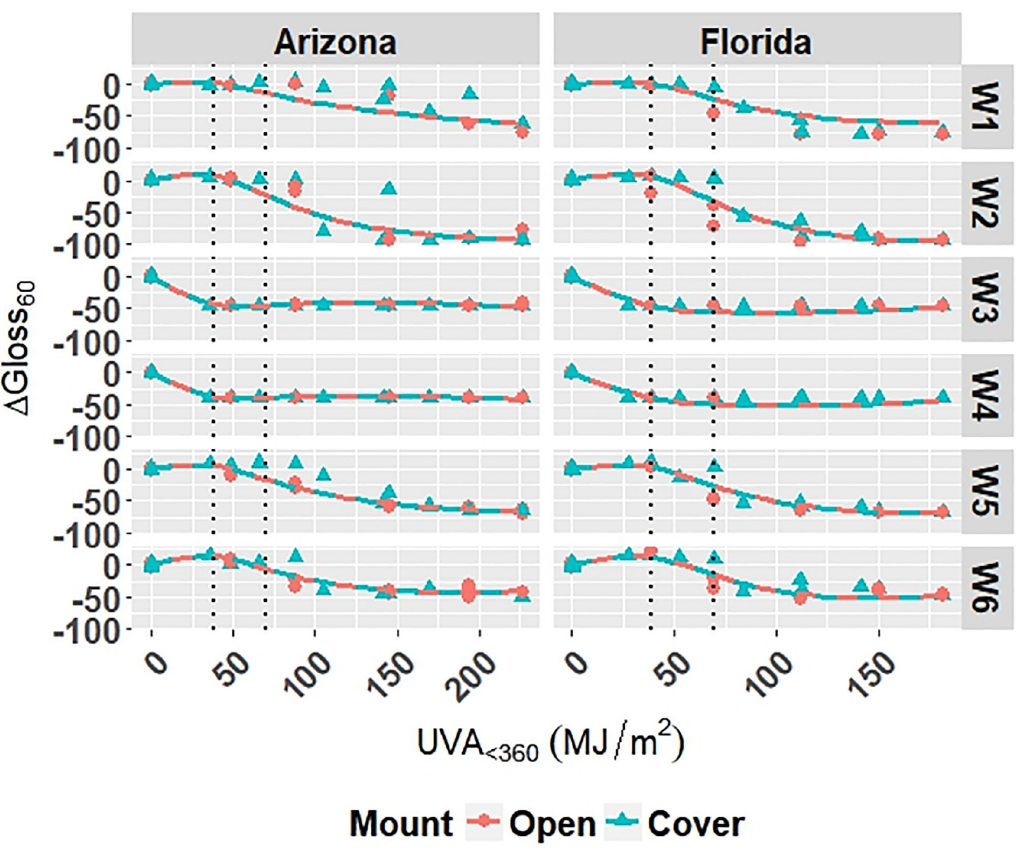
Fig 5. The change in Δ Gloss 60 for white grades of PET under outdoor exposures with the model curves superimposed on the data. Points represent the measured data and solid and dashed lines represent the models. Vertical, dotted lines represent the location of natural spline knots.